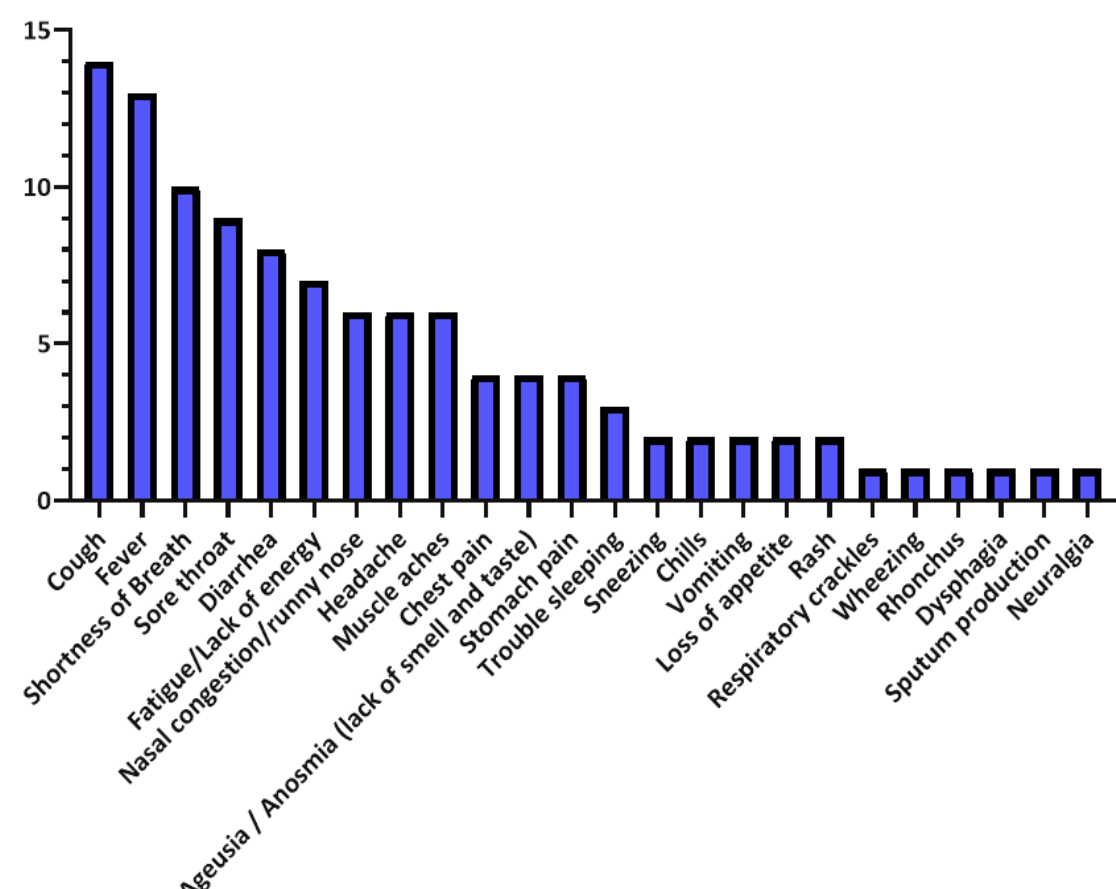
Figure 4. Vital signs’ distribution in the reviewed studies.